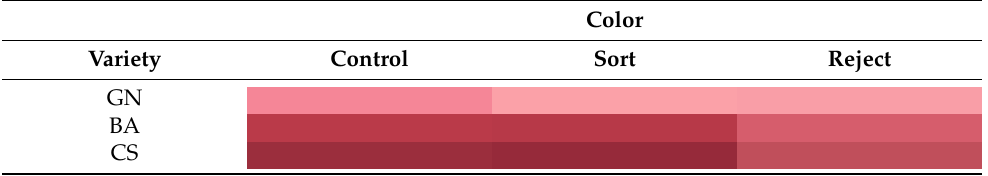
Table 11. Wine colors determined from CIELAB values measured using a CR-400 Chroma Meter within 6 months of sensory analysis. CIELAB values were converted to colors using Colorizer.org.